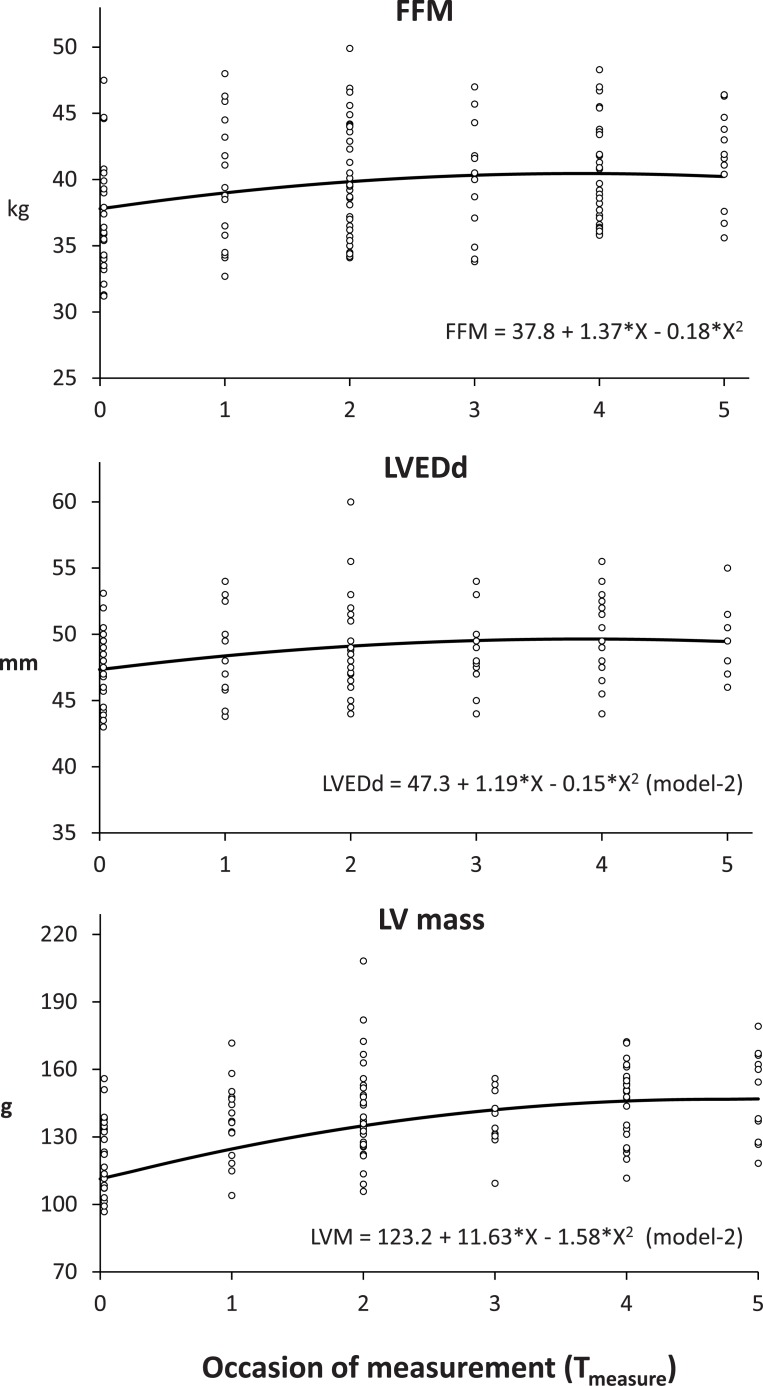
The trajectories of changes in fat-free mass (FFM), left ventricular end-diastolic dimension (LVEDd), and left ventricular mass (LV mass) among adolescent female distance runners.Occasion of measurement (Tmeasure) is numbered from 0 (baseline) with a 1-unit increase representing 6 months. Open circles represent individual data. X in the polynomials denotes Tmeasure.